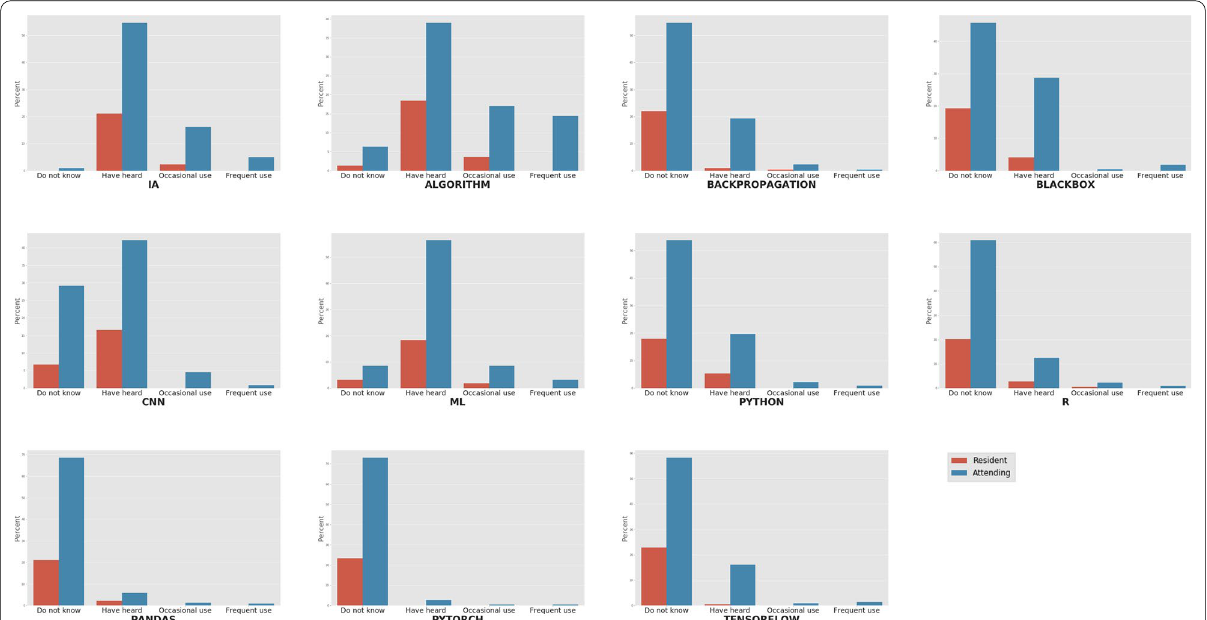
DK do not know, HH have heard, OU occasional use, FU frequent use. Statistically significant results are marked (*). Note no “frequent use” responses for the resident